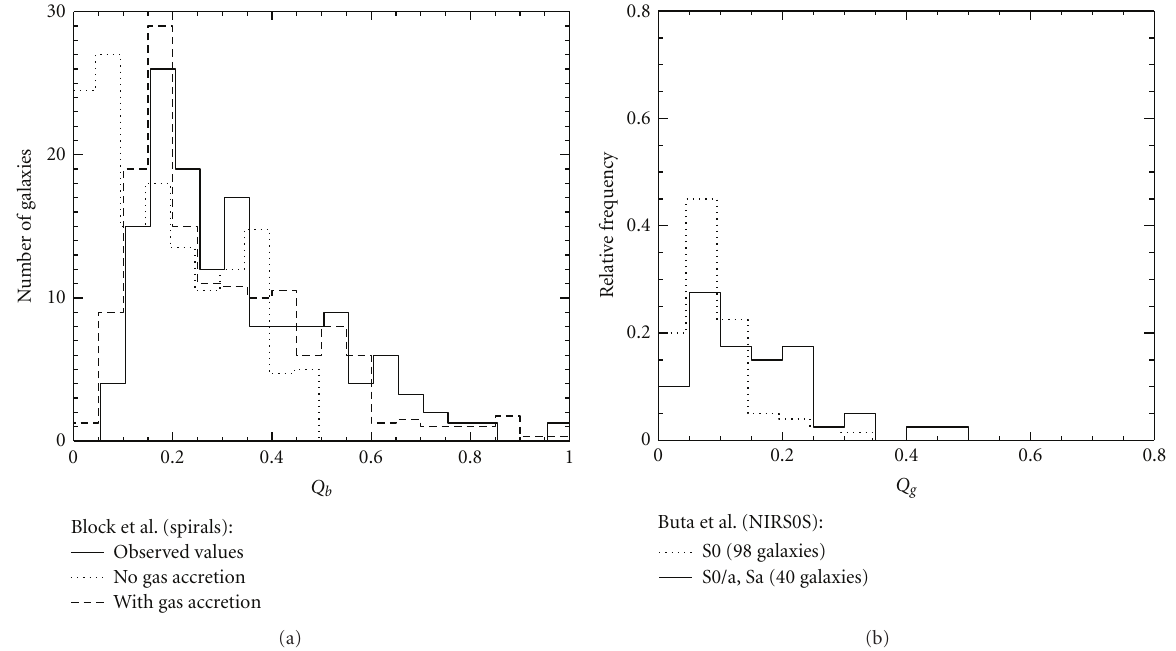
Figure 5: (a) the observed Q g distribution for spirals in the OSUBSGS (cover the Hubble types up to T = 9), taken from Block et al. [54], compared with the simulation models by Bournaud and Combes [55]. The solid line shows the observed values from Block et al., the dotted line is the model with no gas accretion, and the dashed line shows the model that doubles the total galaxy mass in 10 10 years. (b) the observed Q g distributions for the S0s and early-type spirals in NIRS0S, taken from Buta et al. [56]. Notice that Q b in Block et al. [54] in (a) has the same meaning as Q g in Buta et al. [56] in